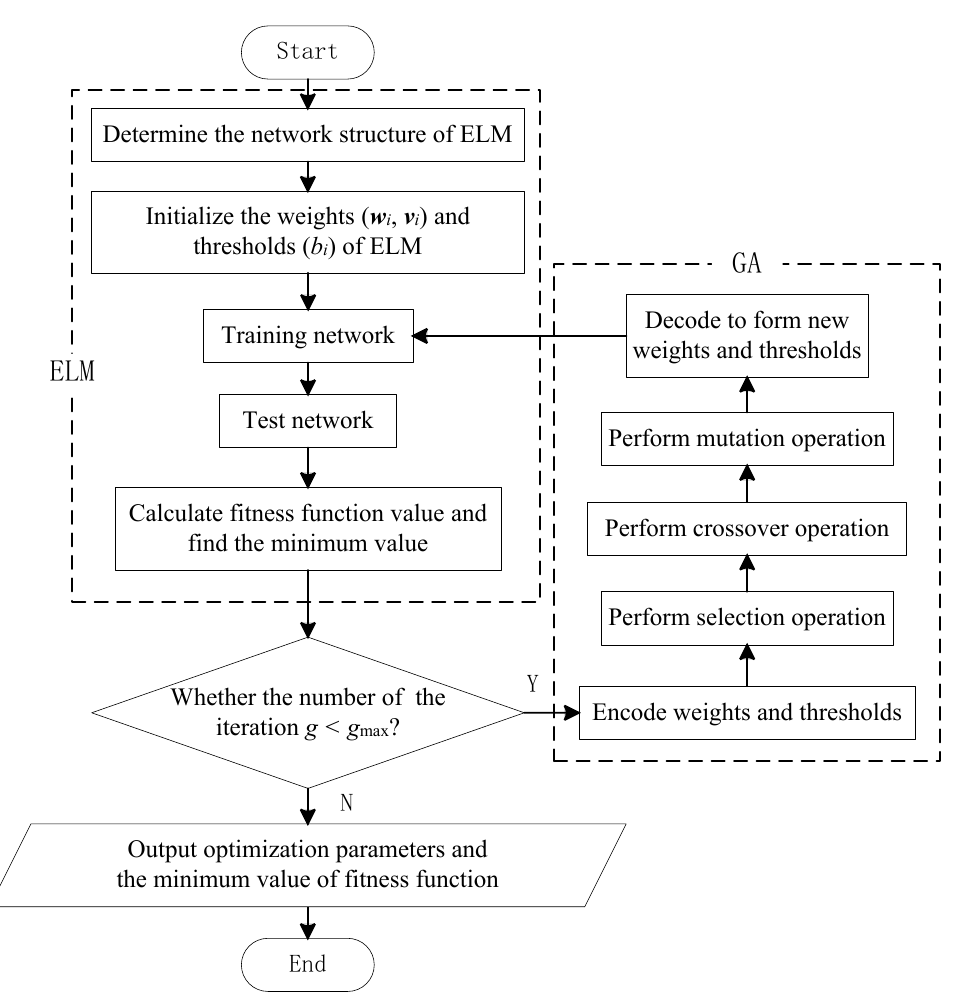
Figure 4. Workflow chart of GA-ELM